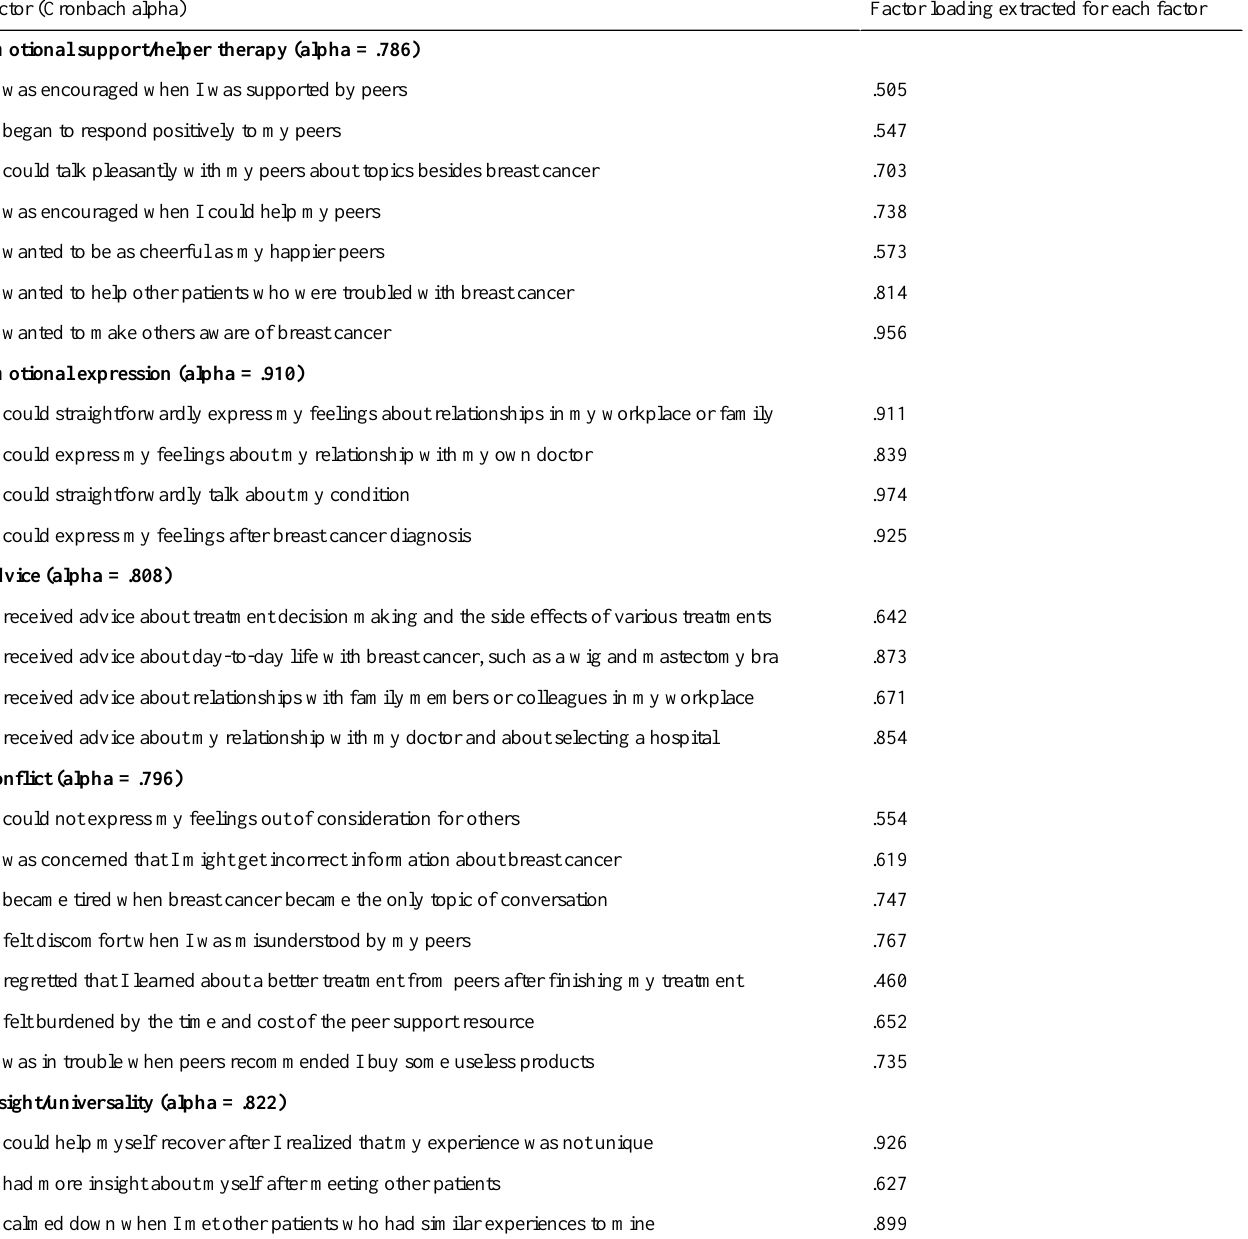
Factor loading extracted for each factorFactor (Cronbach alpha)